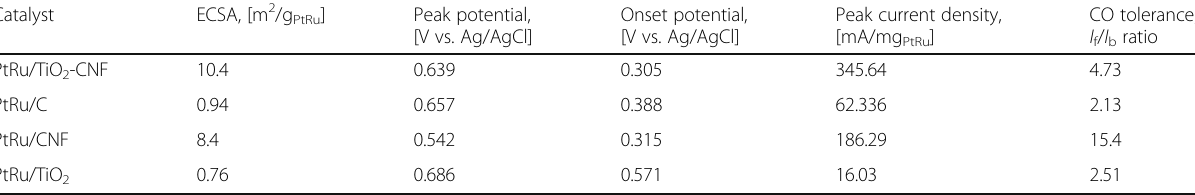
Table 4 Comparison of the current density results with the different catalyst supports Catalyst ECSA, [m 2 /g PtRu ] Peak potential,